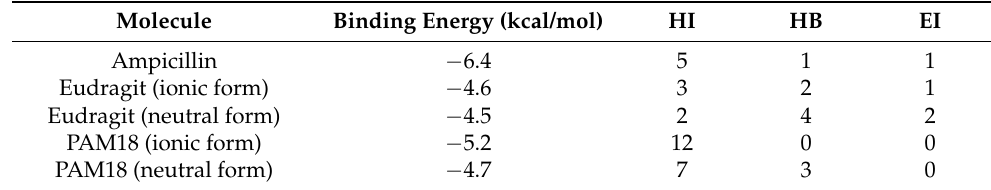
Table 1. Number, type of interaction and binding energy between the different ligands and the PBP2a protein. Molecule Binding Energy (kcal/mol) HI HB EI Ampicillin − 6.4 5 1 1 Eudragit (ionic form) − 4.6 3 2 1 Eudragit (neutral form) − 4.5 2 4 2 PAM18 (ionic form) − 5.2 12 0 0 PAM18 (neutral form) − 4.7 7 3